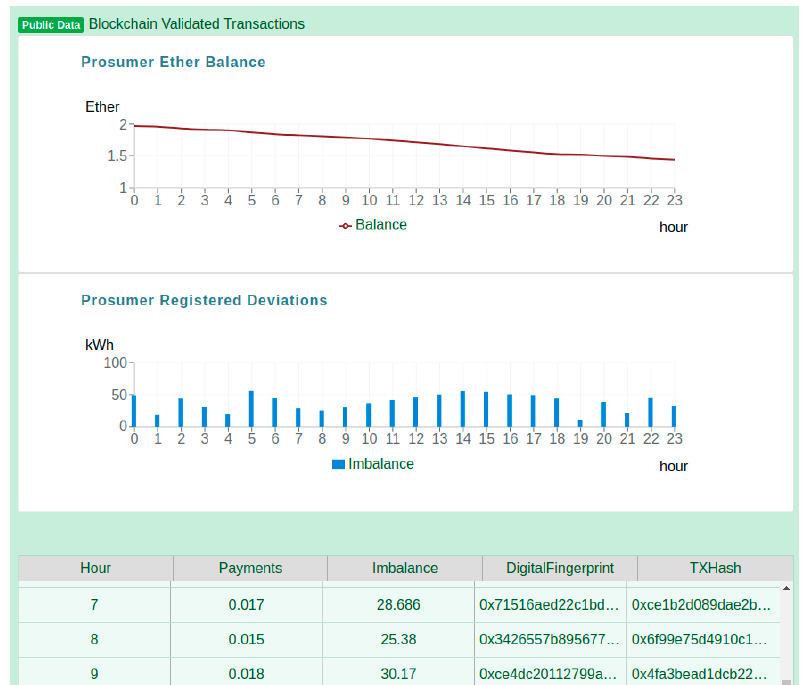
Figure 10. Prosumer’s public energy data registered in the blockchain platform.